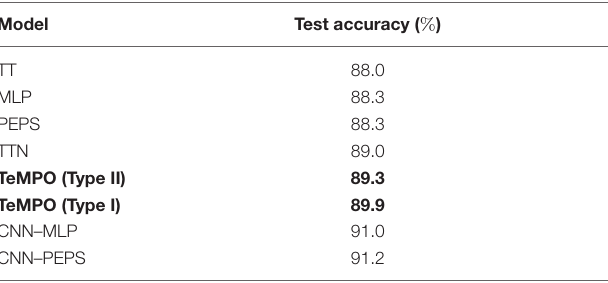
TABLE 2 | The test accuracy of different models for the Fashion MNIST